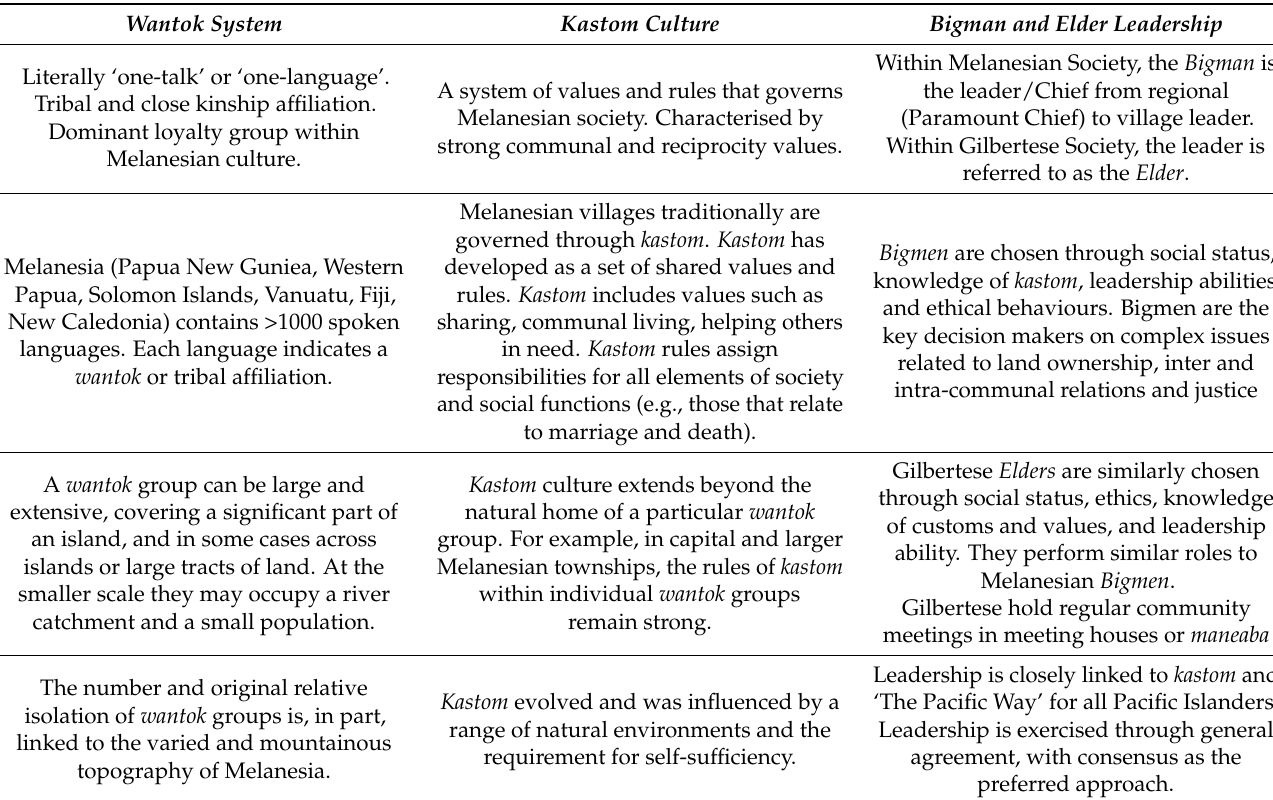
Table 2. ‘The Pacific Way’ Systems and Values: Wantok , Kastom , Bigman and Elder . Wantok System Kastom Culture Bigman and Elder